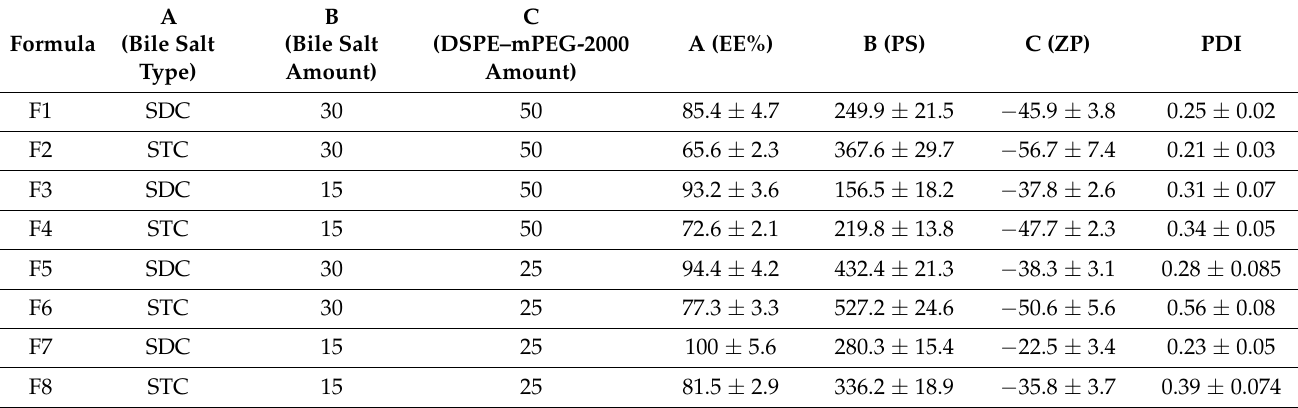
Table 2. 2 3 full factorial experimental design; experimental runs, independent variables and estimated responses of 4e-loaded PEGylated